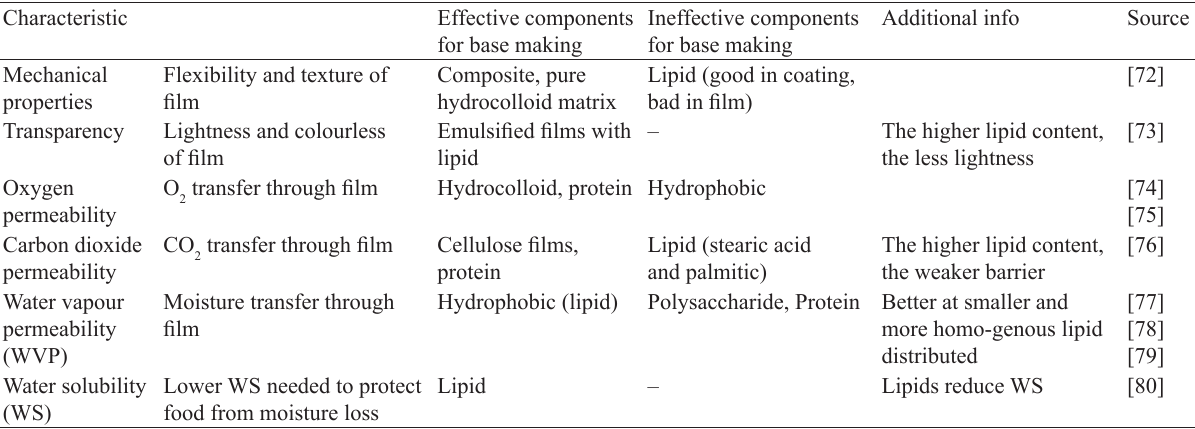
Table 3 Edible film characteristics